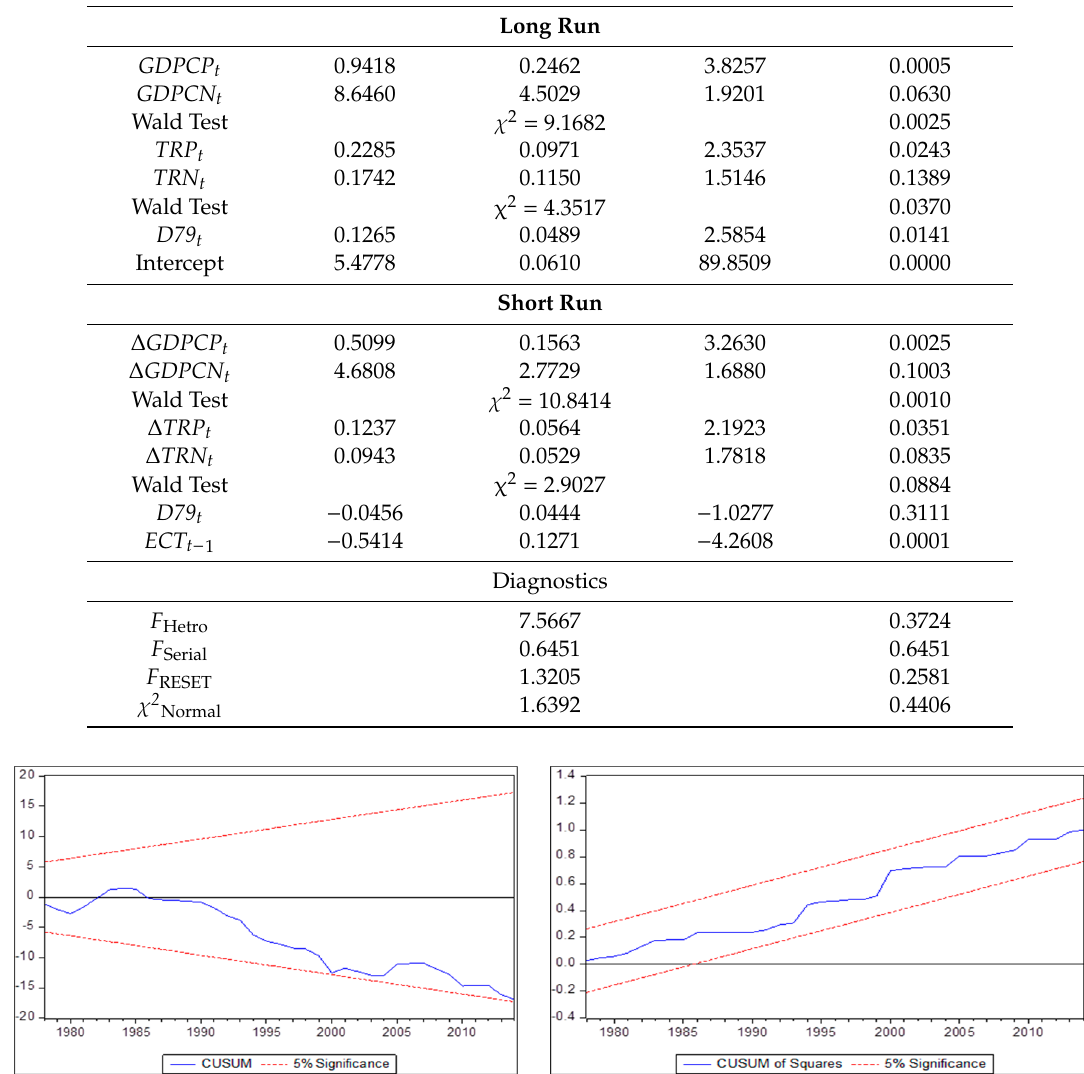
Figure 1. CUSUM and CUSUMsq Tests.